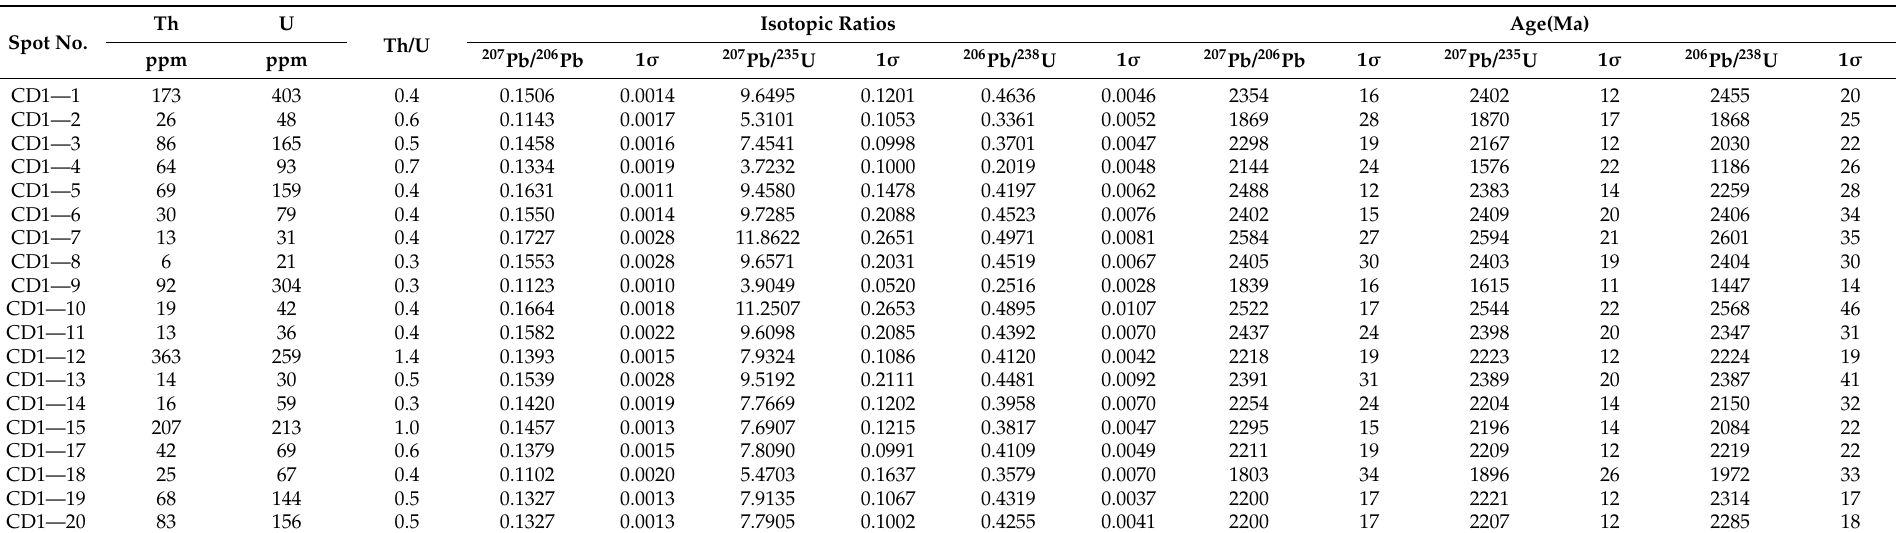
Table 1. LA-ICP-MS zircon U-Pb dating results for the Gaositai hornblendite.